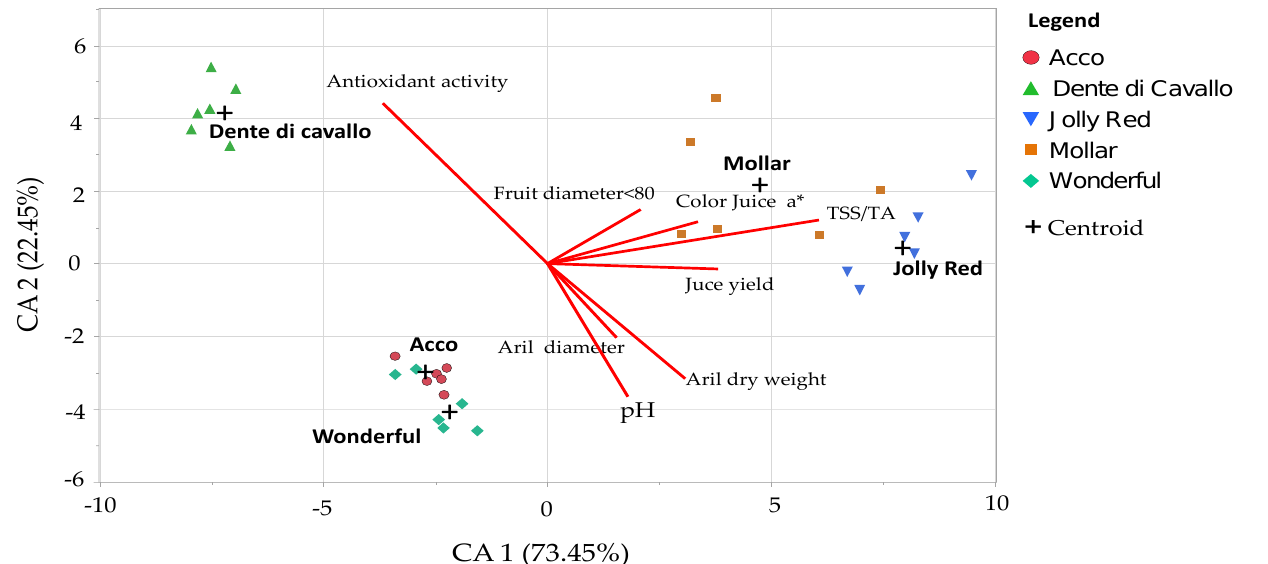
Figure 3. Stepwise discriminant analysis biplot of the morpho-quality parameters of considering the cultivar as the discriminant variables.